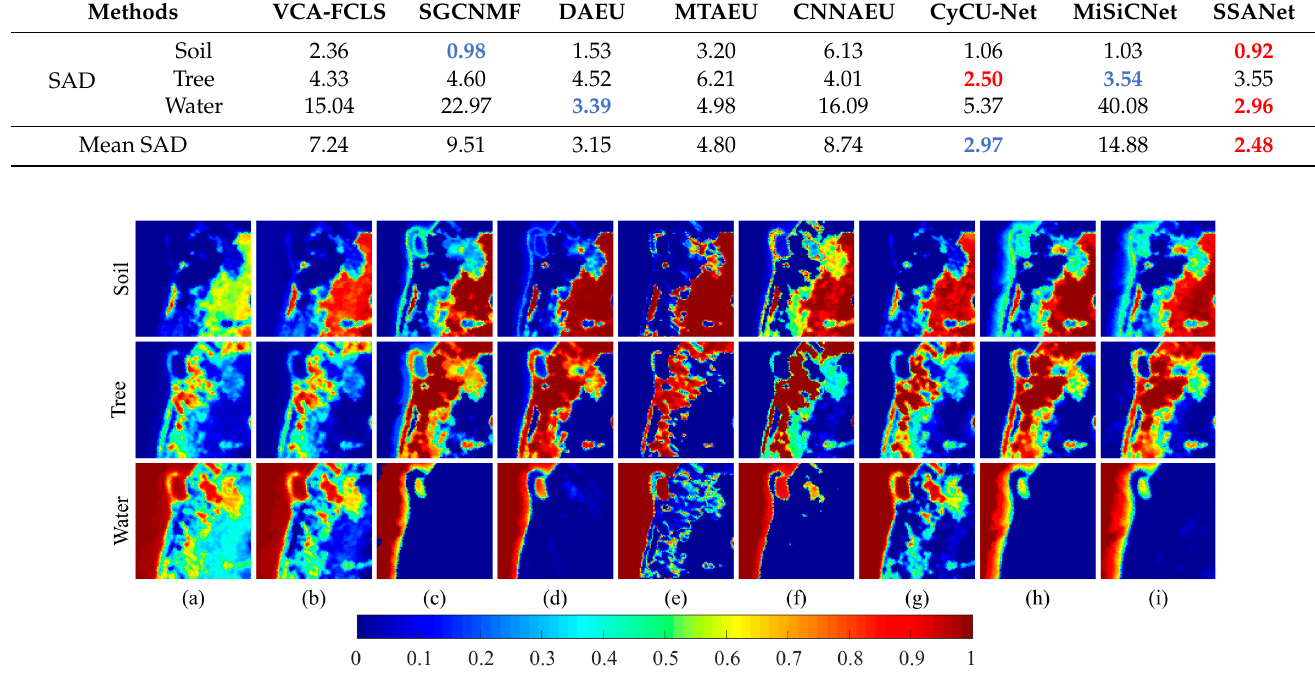
Table 3. SAD ( × 100) and mean SAD ( × 100) of endmembers acquired by various unmixing ap- proaches on Samson data. Annotation: bold red text indicates the best results and bold blue text indicates the suboptimal results.